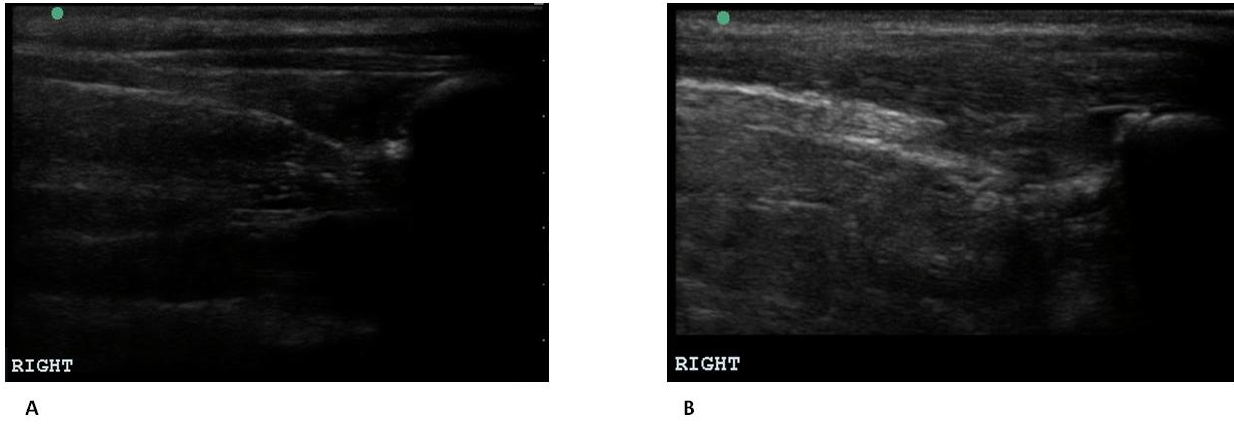
Figure 2 : Grade I Strain A- Longitudinal view of grade I strain of common tendon Evidence of right CT early disruption with mild hyperechoic/hypoechoic foci noted at the point of insertion. B- Longitudinal view of grade I strain of common and gastrocnemius tendons There was a generalised hypoechoic fibre pattern to the CT and GT with no disruption noted. In addition the common tendon bursa also showed chronic hyperechoic changes consistent with